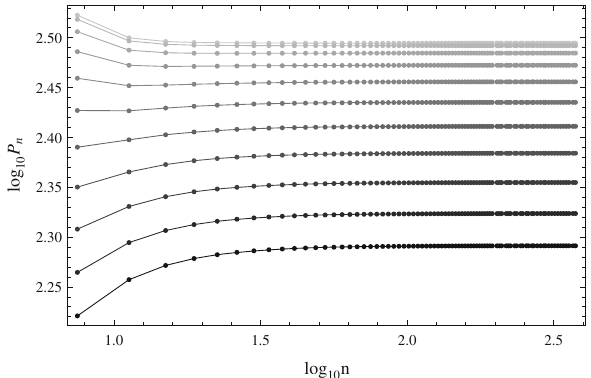
Fig. 3 The power spectrum obtained by numerically solving the per- √ turbations with ˜ m = 0 . 1 × { 0 , 1 ,..., 10 } , from top to bottom. All √ spectra are plotted with H 0 = 8 π/